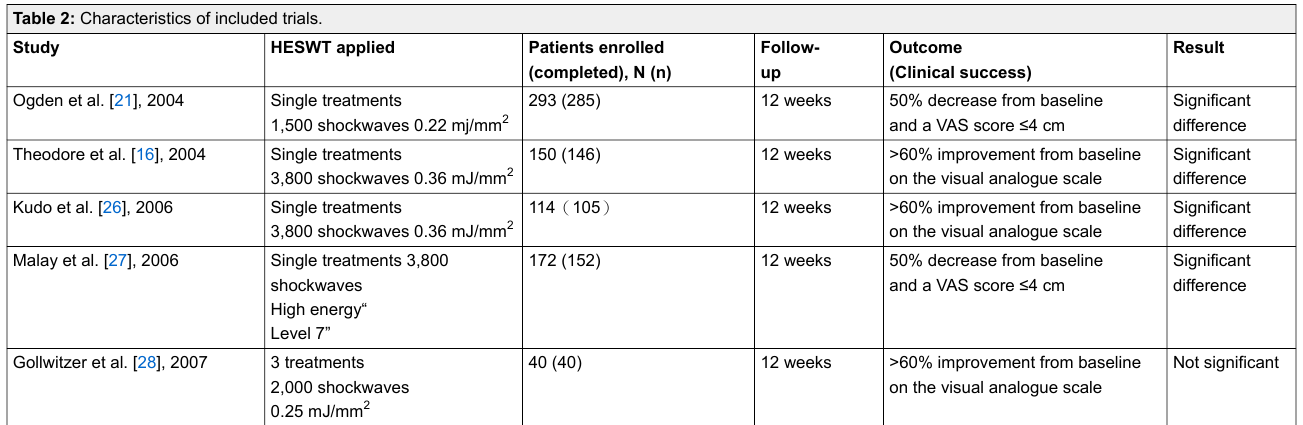
Table 2: Characteristics of included